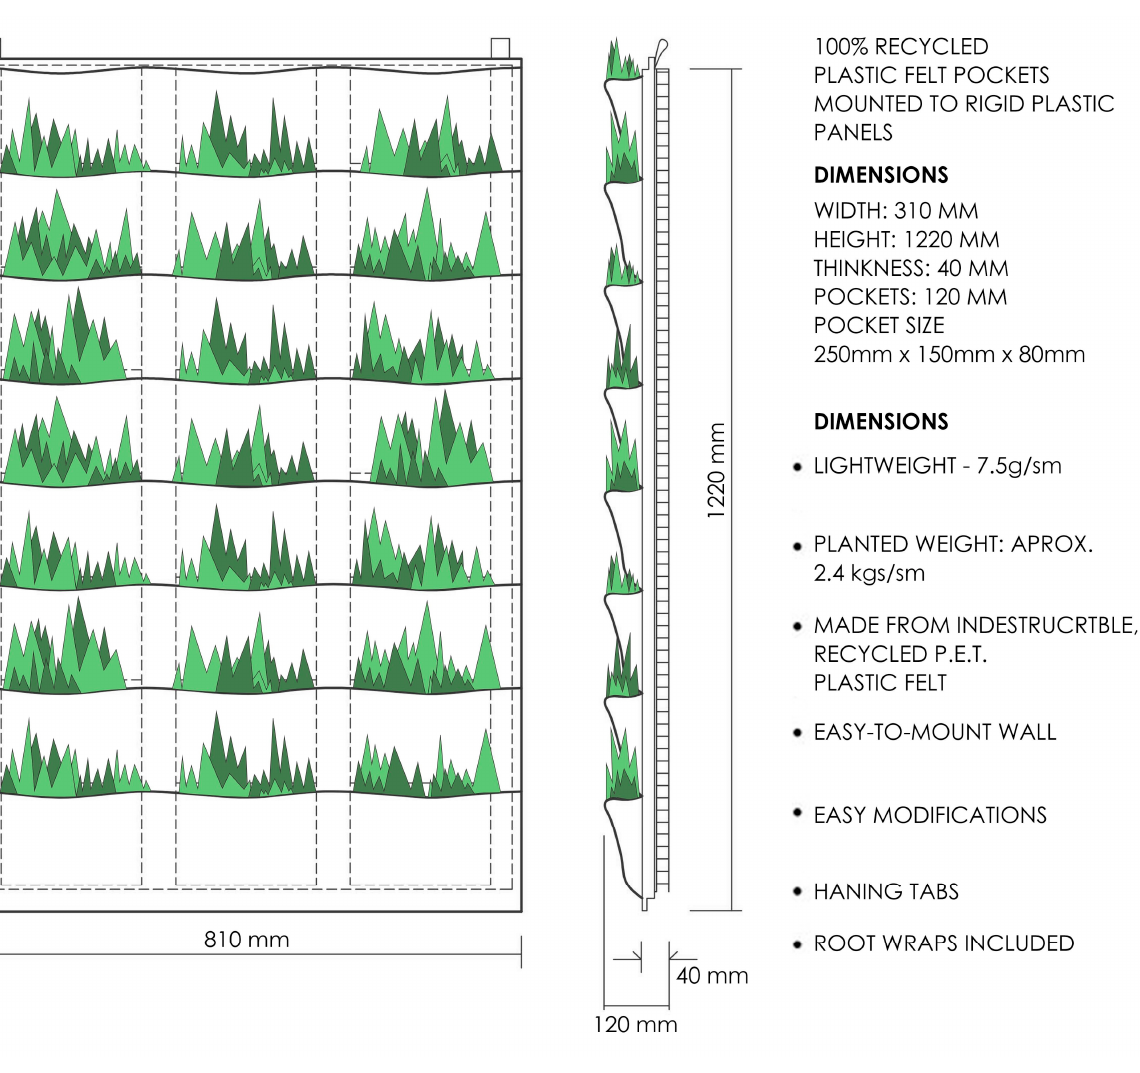
Figure 8. Pocket living wall system based on